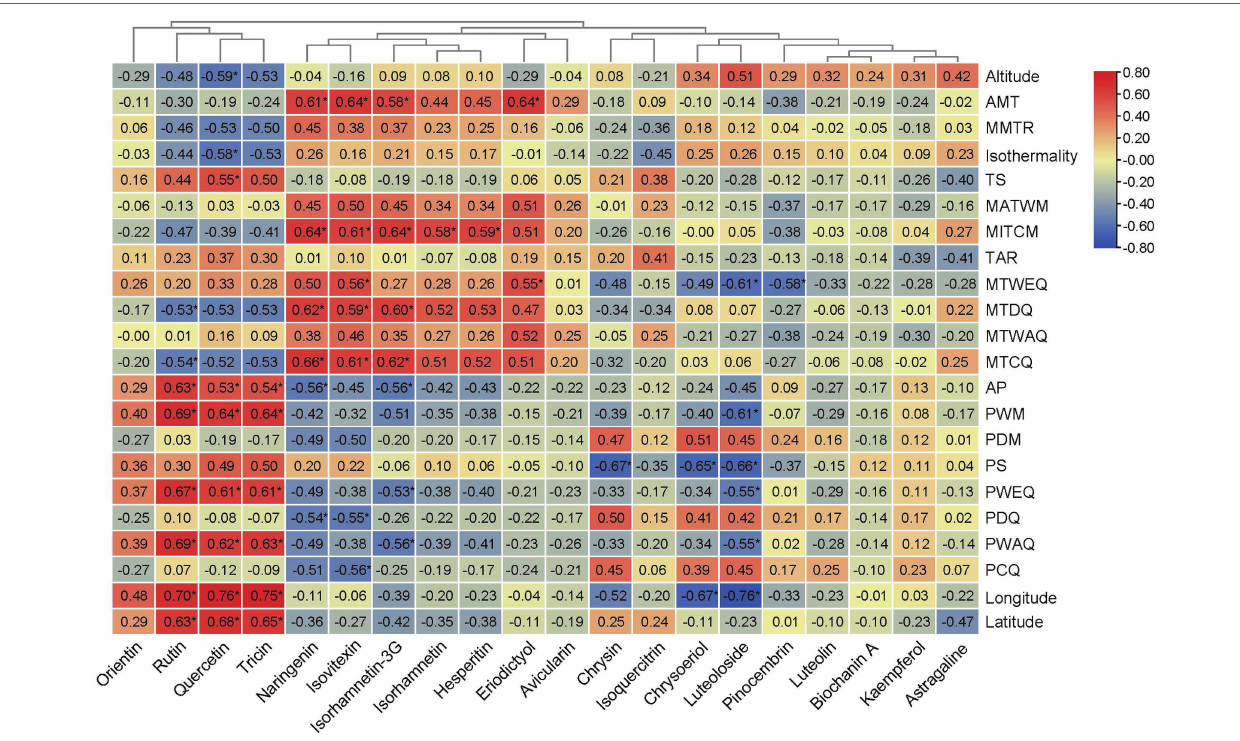
FIGURE 5 | Cluster heatmap based on correlation between flavonoid metabolites and the environmental variables. Red represents positive correlation, blue represents negative correlation. *Indicates statistical significance ( p <